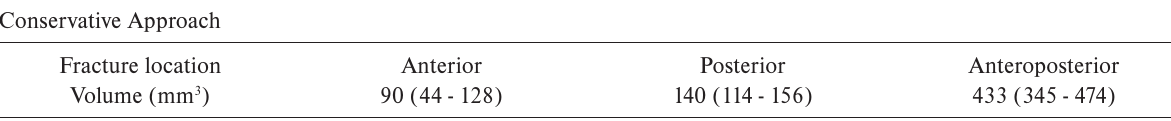
Table 2. Prolapsed volumes in blow-out fractures/conservative therapy.